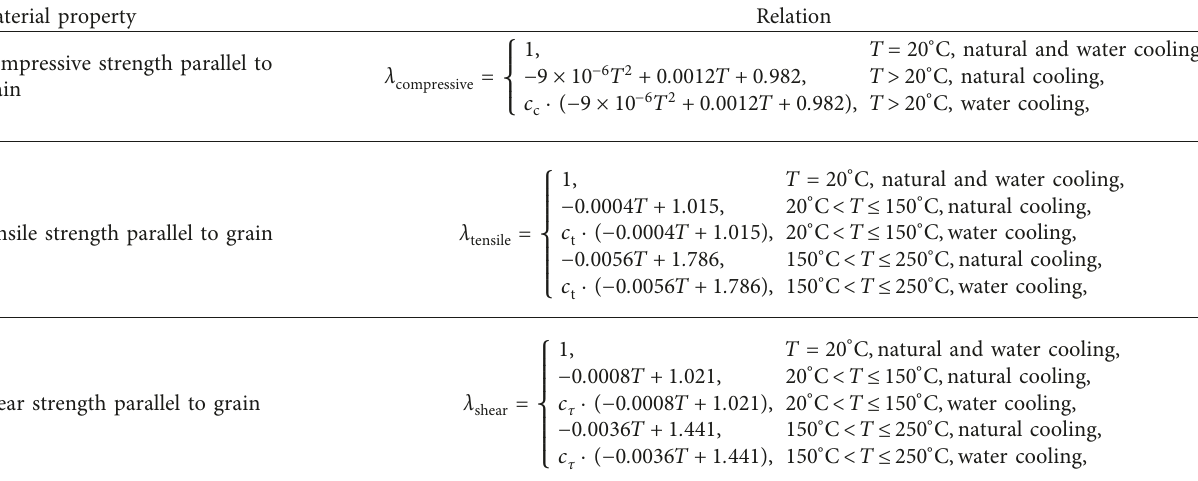
Table 2: Degradation model of high temperature unstressed material property relationships for wood.